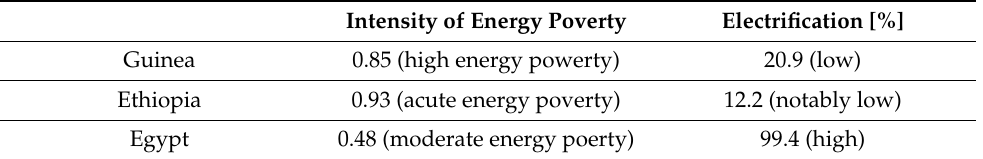
Table 5. Energy poverty in Guinea, Ethiopia and